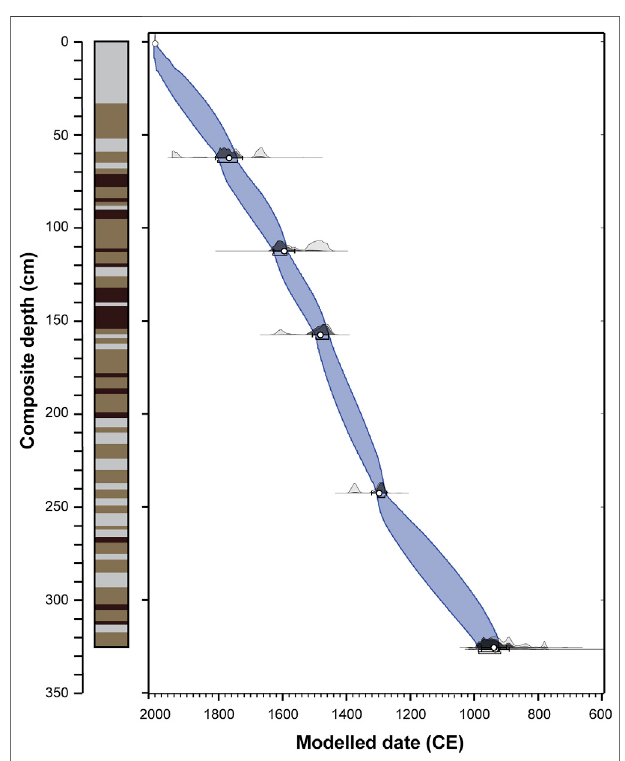
FIGURE7| Age-depthmodelfortheGBWcorewithgreylinesindicating con fi dence limits and blue curve showing age-depth interpolation.